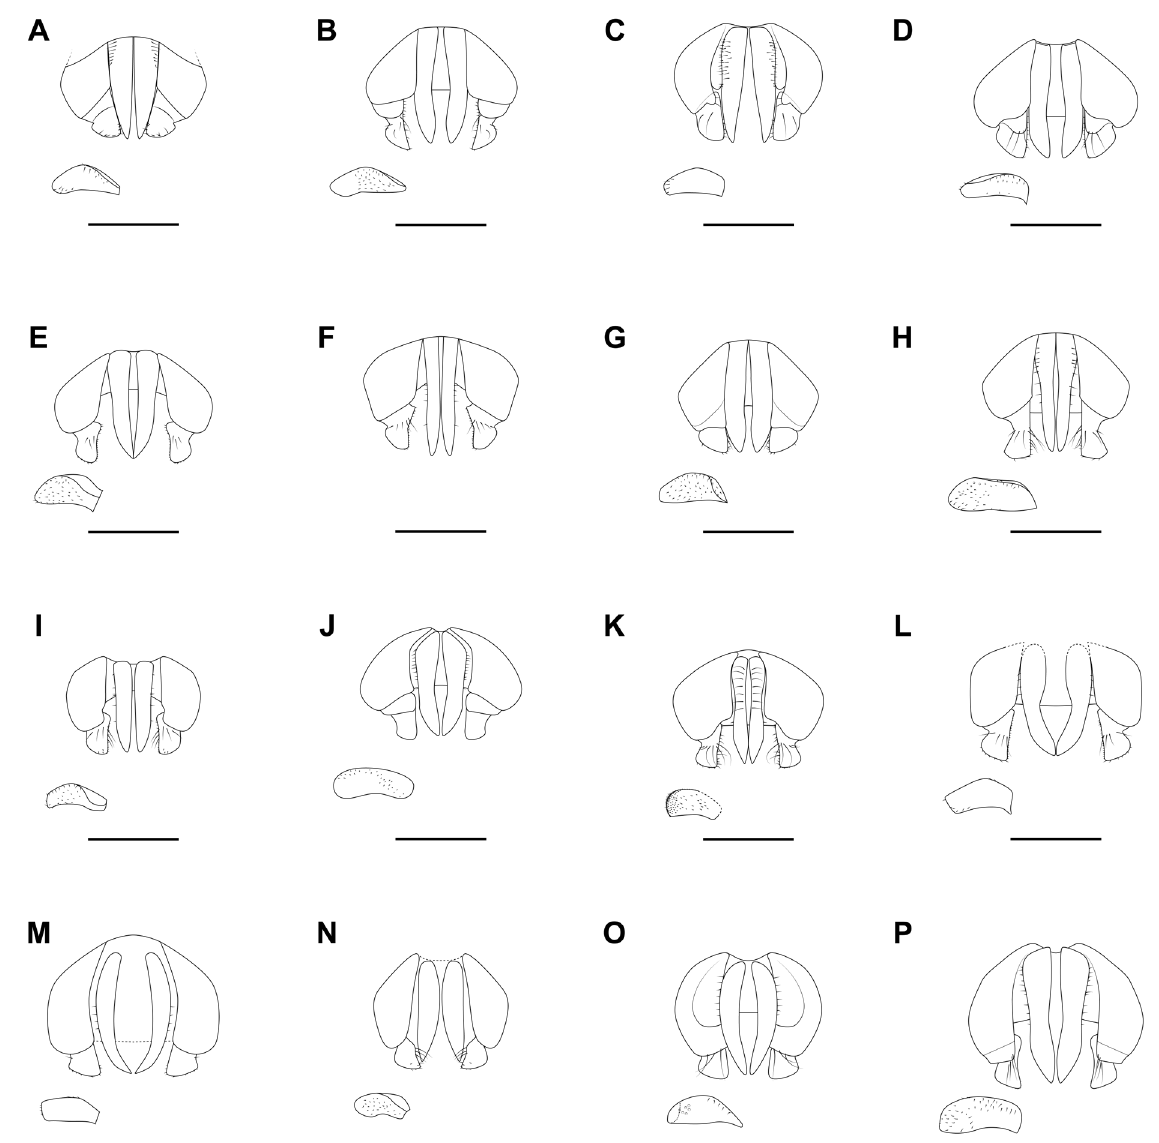
Fig. 76. Male genitalia illustrated in dorsal view and positioned such that the gonostylus is parallel to the plane of vision. Retrorse lobes are also illustrated separately to the bottom left of each figure in lateral view, positioned parallel to the plane of vision. A . Lasioglossum ( D .) angelicum sp. nov. B . L . ( D .) coactus (Cresson, 1872). C . L . ( D .) deludens sp. nov. D . L . ( D .) diabolicum sp. nov. E . L . ( D .) gaudiale (Sandhouse,